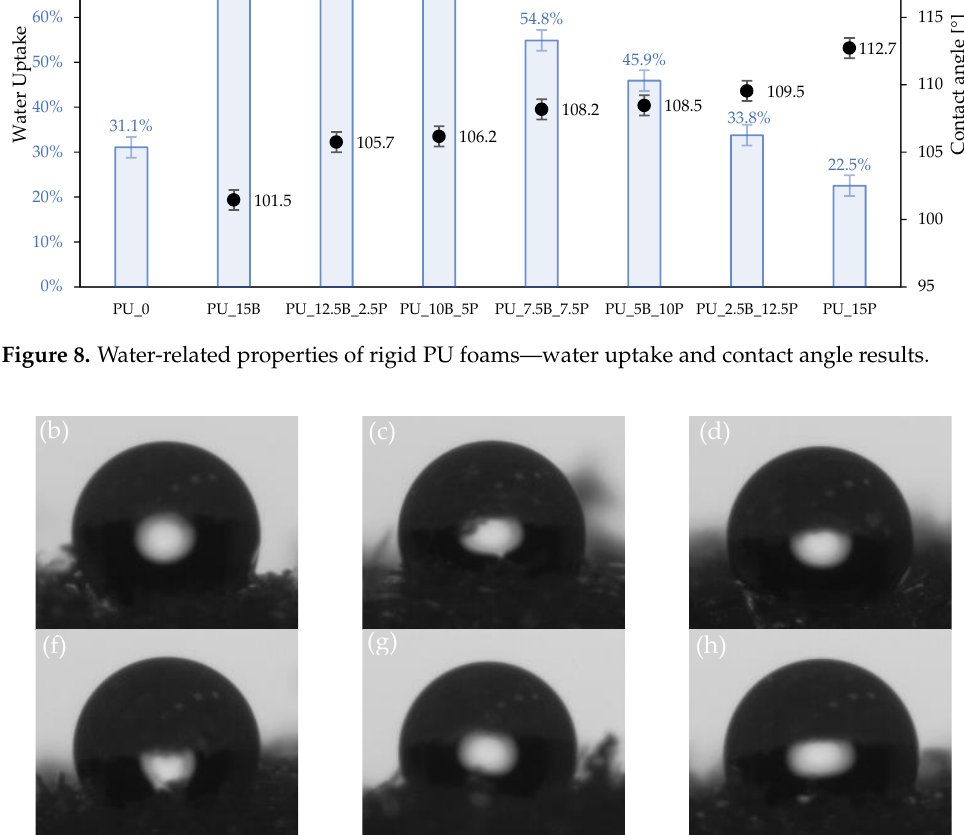
Figure 9. Images of contact angle examination for ( a ) PU_0, ( b ) PU_15B, ( c ) PU_12.5B_2.5P, ( d ) PU_10B_5P, ( e ) PU_7.5B_7.5P, ( f ) PU_5B_10P, ( g ) PU_2.5B_12.5P, and ( h ) PU_15P.